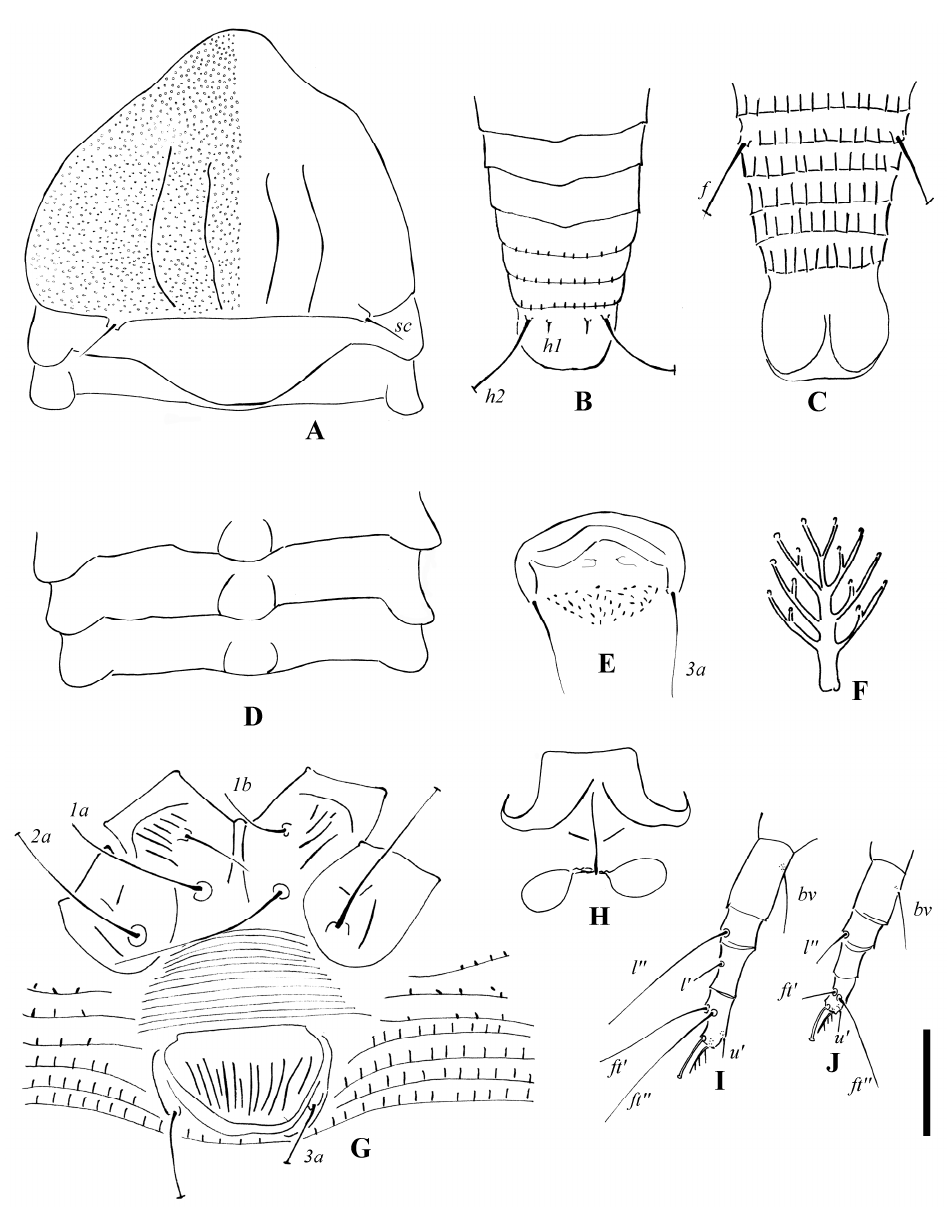
(17–18) apart. Internal genitalia: spermathecae ovoid, oriented posterolaterad; spermath- ecal tubes relatively short, as long as 1/3 of spermathecal length; transverse genital apodeme trapezoidal.